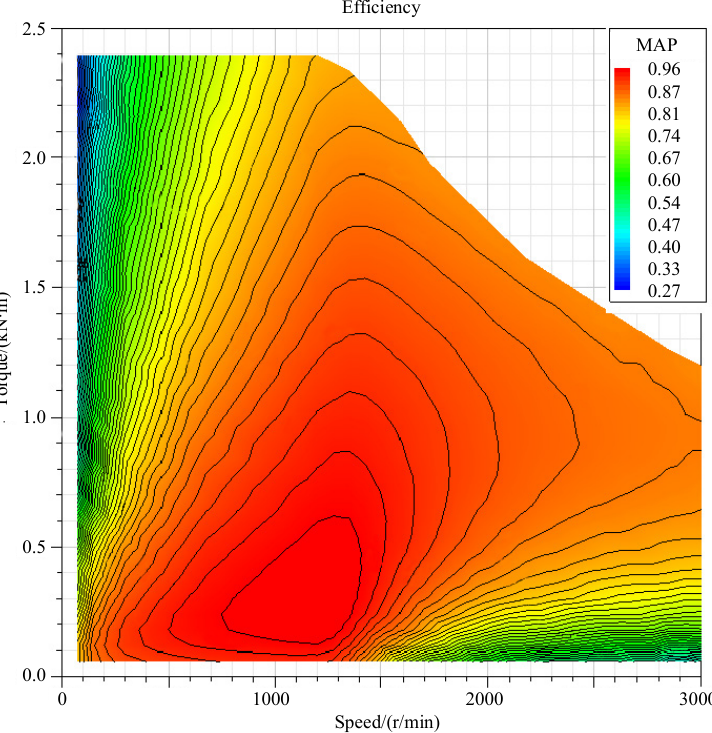
Figure 6. The efficiency map of an electric motor in the walking system.